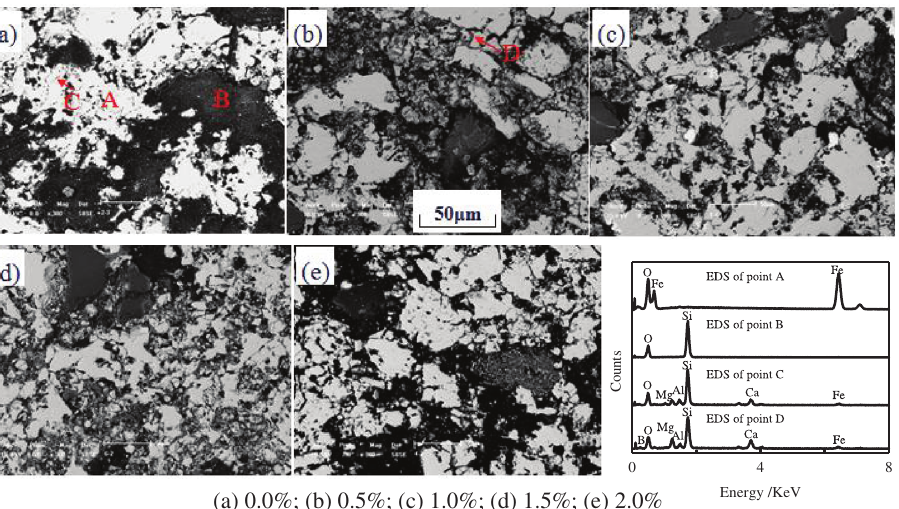
Figure 4: Photos of SEM and EDS of pellets with different content of boron mud after reducing (a) 0.0%; (b) 0.5%; (c) 1.0%; (d) 1.5%; (e) 2.0%.